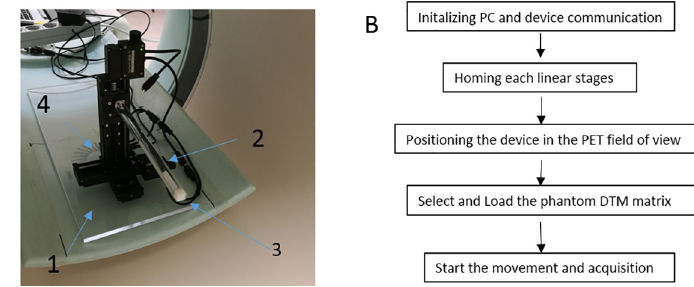
Fig 1. Positioning system (A) and the flow diagram of the measurement procedure (B) The positioning system is consist of a plastic holder (arrow 1), plastic rod (arrow 2), 22 Na point source (arrow 3), and linear stages (arrow 4).